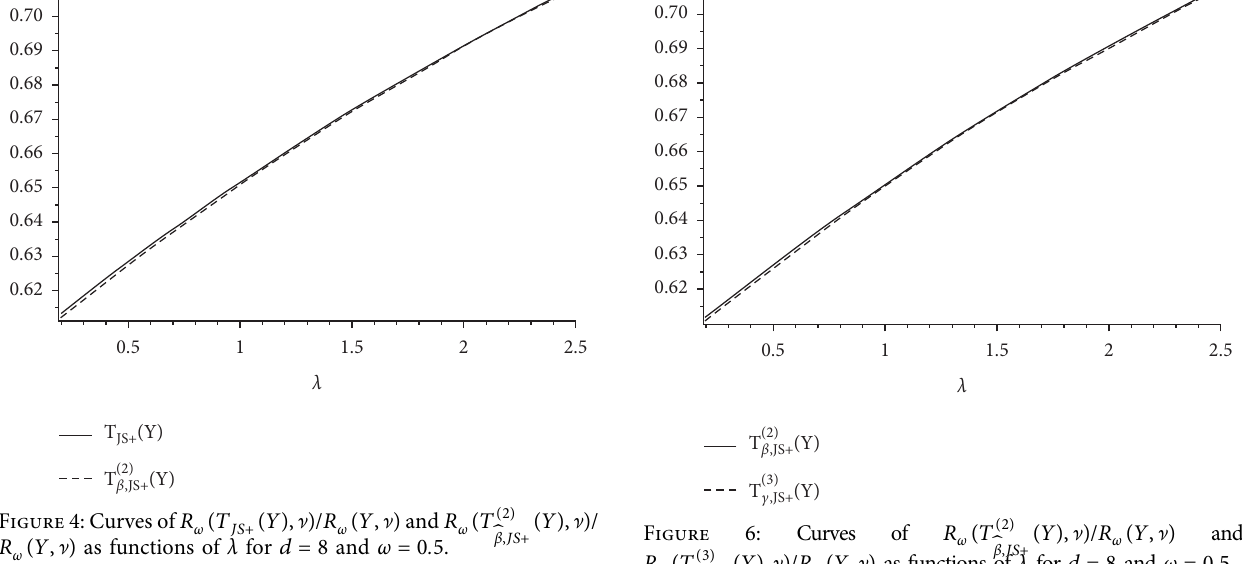
( Y, ] ) as functions of λ for d � 8 and ω � 0 . 5. ω